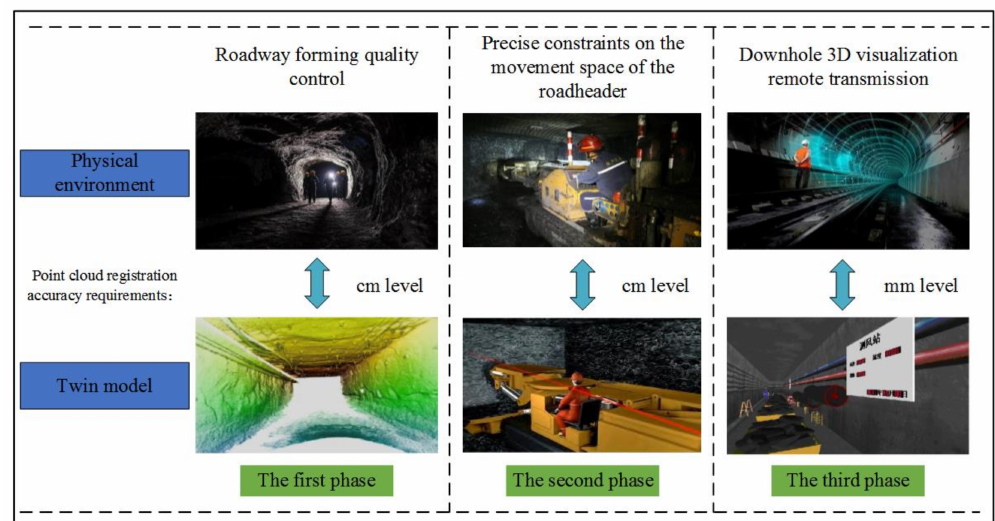
Figure 14. Accuracy requirements of an underground tunneling